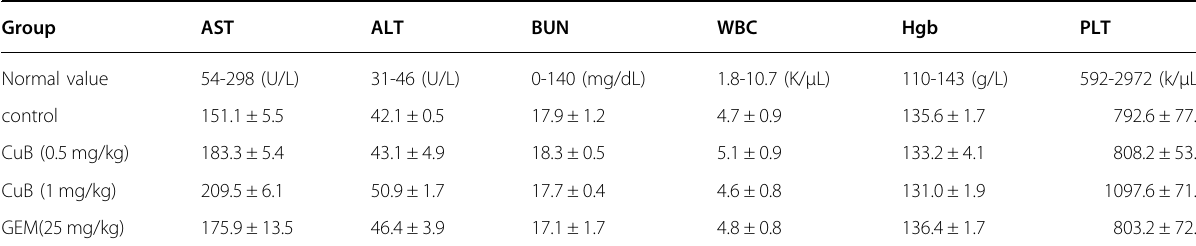
Table 2 Blood level of different biochemical parameters among study groups.